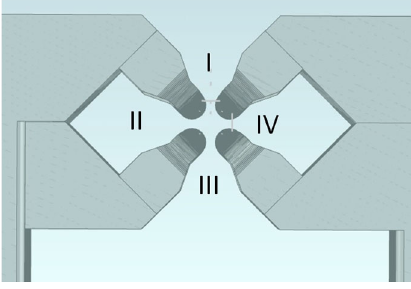
FIG. 9. A cross-sectional view of each quadrant in the RFQ.